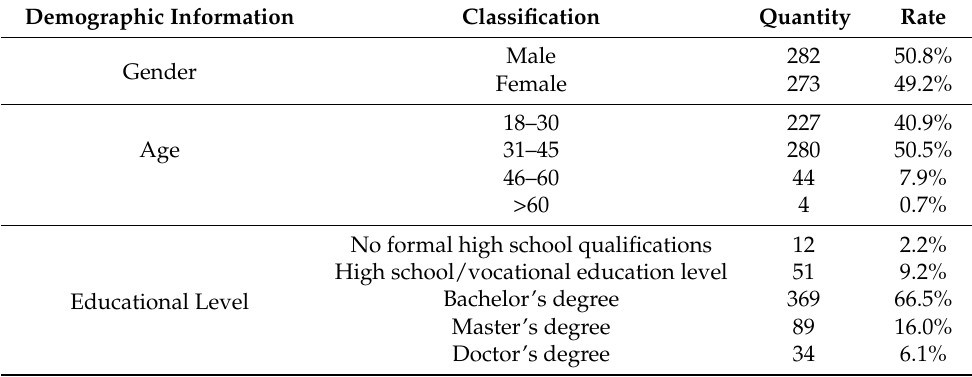
Table 2. Basic demographic analysis of the